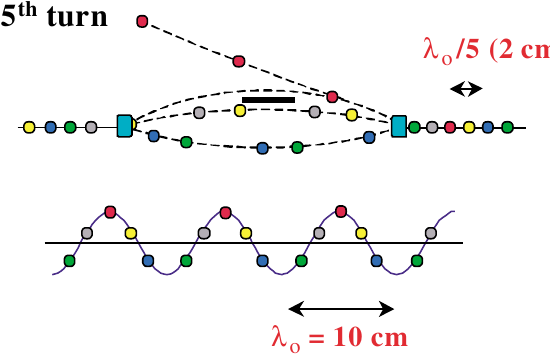
FIG. 3. (Color) Fifth passage of the first injected bunch train in the injection region for a combination with a multiplication factor of 5.